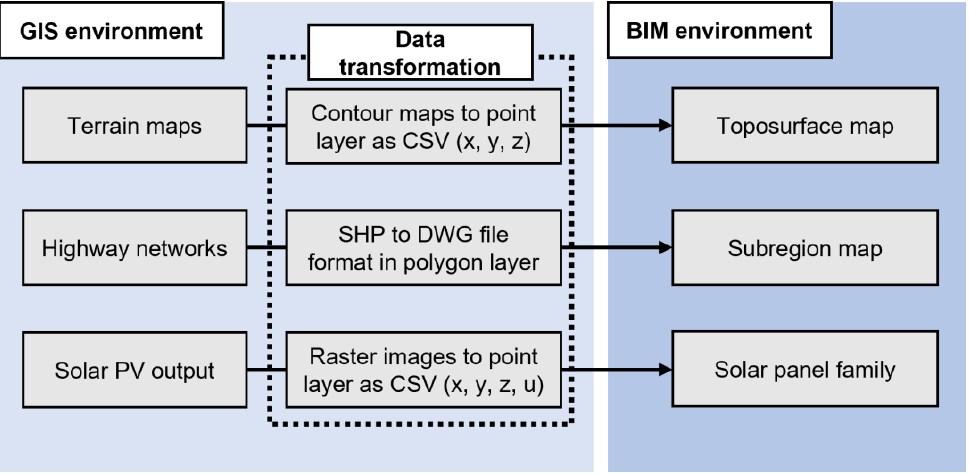
Figure 5. Conceptual illustration of data transformation for the integration of BIM and GIS.